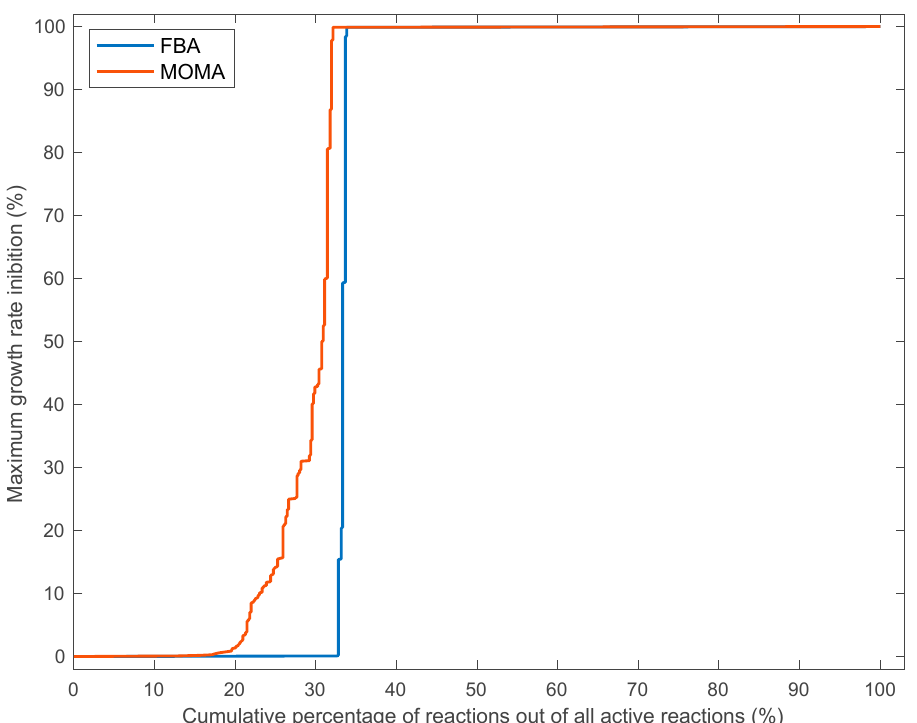
Figure 3. Cumulative percentage of active reactions, for which deletion of each reaction (taken independently) decreased the growth rate by a proportion equal to the value on the Y-axis or lower. Calculation of intracellular flux distribution and growth rate after single reaction deletion were performed using flux balance analyses (FBA, blue line) or quadratic minimization of metabolic adjustments (MOMA, red line). For instance, the curve describing the reaction deletion with FBA means that a single reaction deletion for around 15% of active reactions does not inhibit growth rate. For around 32% of all active reactions, single reaction deletion decreases growth rate by less than 1%. For around 68% (100 − 32) of all active reactions, single reaction deletion abolishes growth rate, so the cumulative sum on the X-axis gives 100. The other curves can be interpreted analogously.